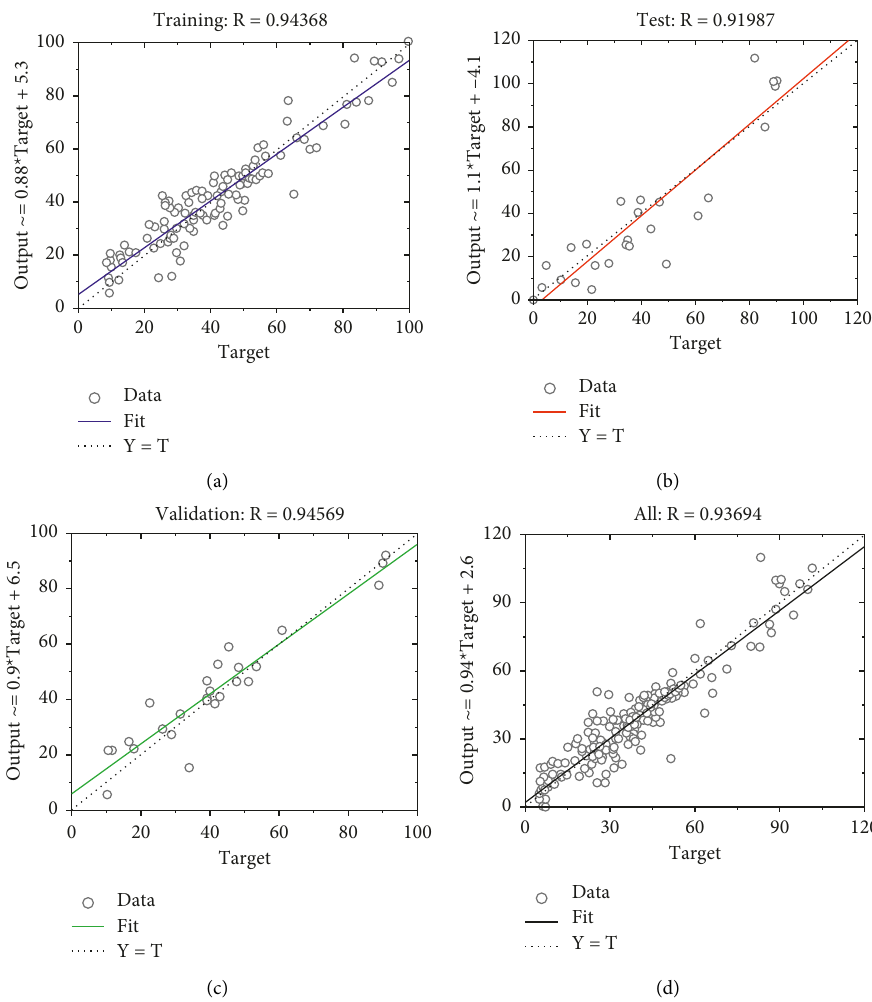
Figure 2: Regression of ANN modeling for prediction of 3d compressive strength of AAS. (a) Training. (b) Testing. (c) Validation. (d)